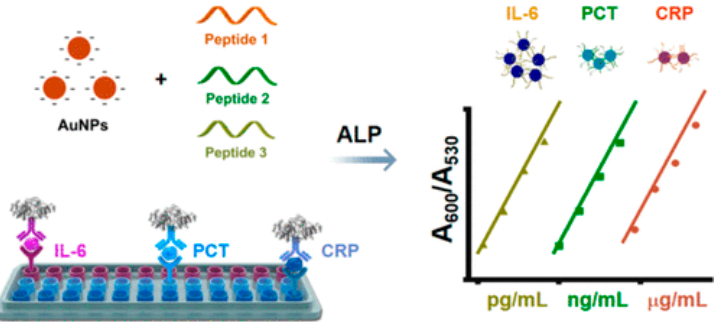
Figure 10. Principle of peptide-ALP-AuNPs immunoassay for simultaneous detection of the inflammatory markers (IL-6, PCT, and CRP). Reproduced with permission from [119]. Copyright American Chemical Society,